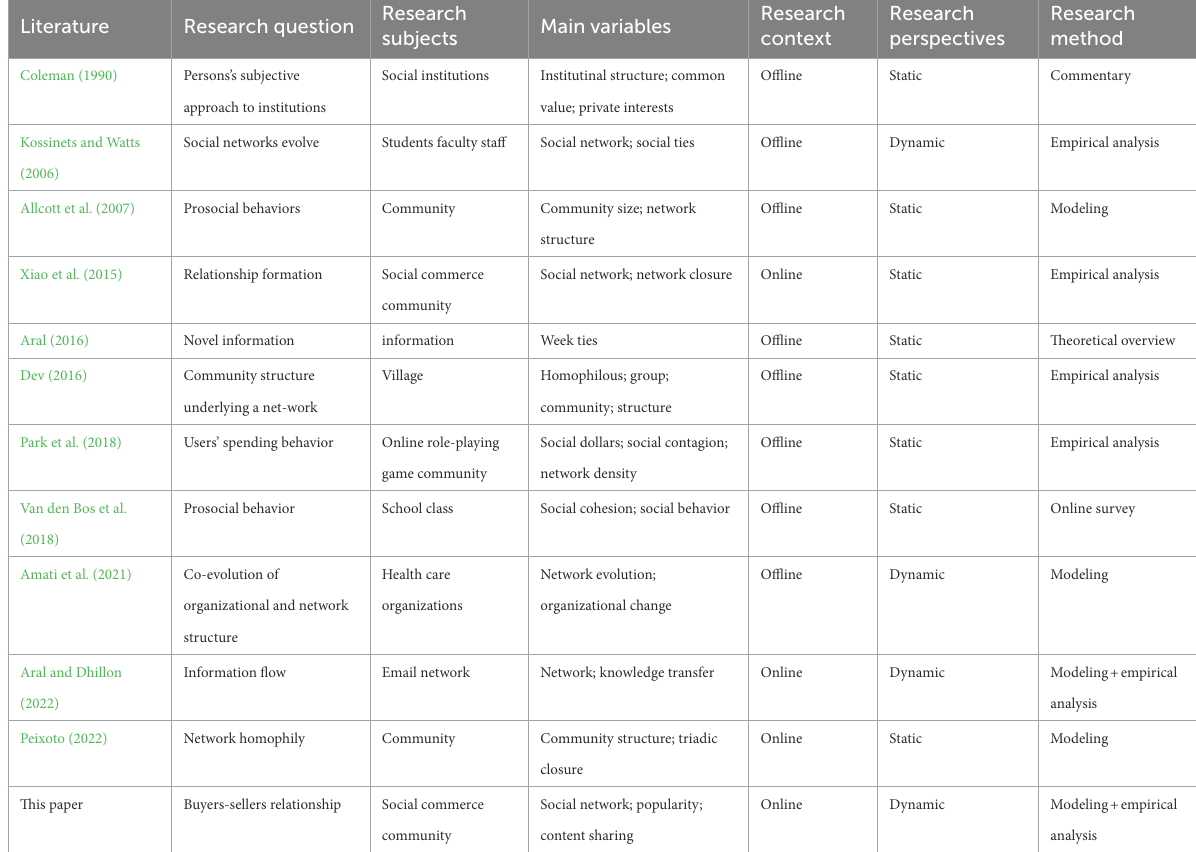
TABLE 1 Selective literature review of network closure